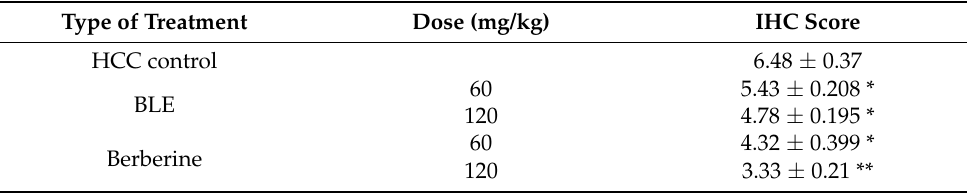
Figure 2. Immunohistochemistry analysis of cyclin D1 (CD1) expression in liver tumor tissue sections. ( A ) Normal mice liver, ( B ) DEN + CCl 4 -treated mice liver, ( C ) BLE treatment at a low dose of 60 mg/kg of mice b.wt, ( D ) BLE treatment at a high dose of 120 mg/kg of mice b.wt, ( E ) berberine compound at a low dose of 60 mg/kg of mice b.wt, ( F ) berberine compound at a high dose of 120 mg/kg of mice b.wt. Scalebar 100 × . Table 3. Comparative scoring of cyclin D1 positive expression based on immunohistochemistry analysis among HCC control and treatments with BLE and berberine at low and high doses, after 60 days of treatment of HCC